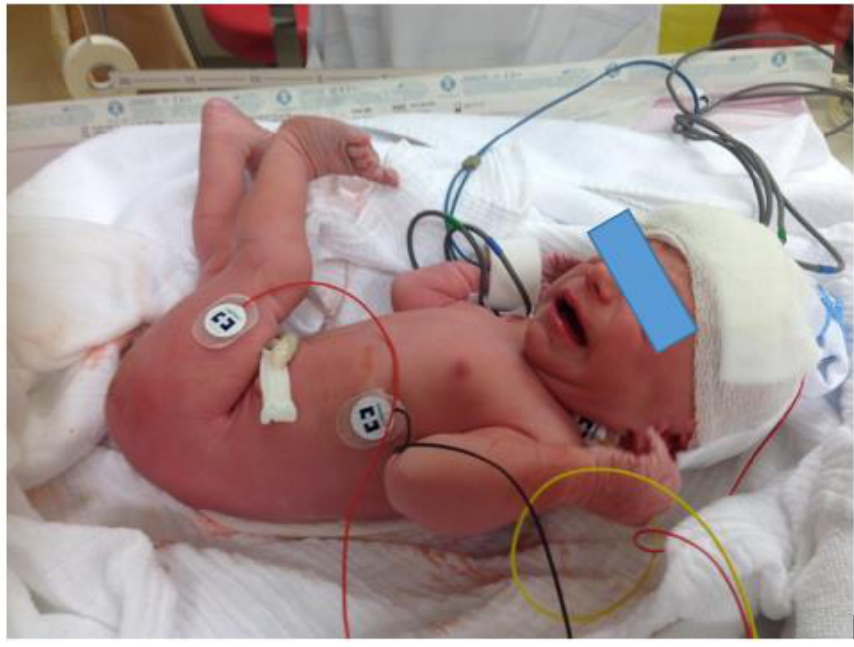
Figure 1. Neonate with four surface electrodes on the left forehead, left side of the neck, left hemithorax, and left thigh for non-invasive CO measurement.